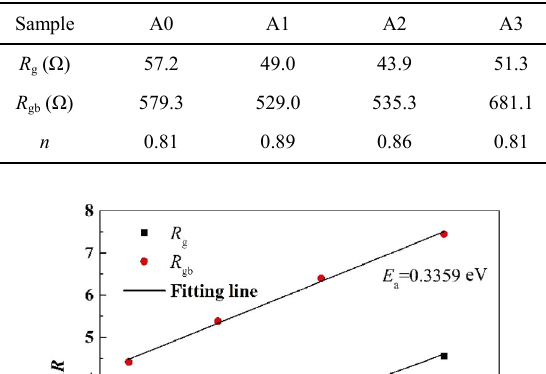
Table 4 Fitted R g , R gb , and parameter n for A0, A1,